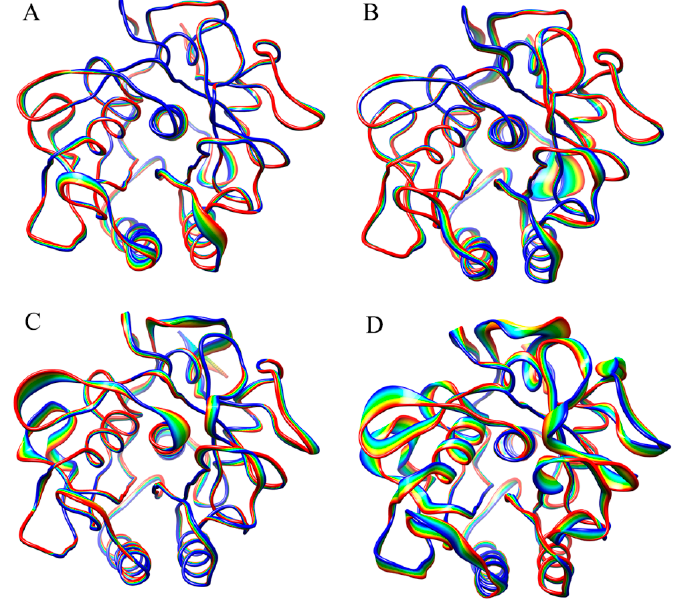
Figure 3. Projection extremes of the first eigenvector obtained from ED analyses of the joined trajectories at the four combined temperatures: ( A ) P180/S180; ( B ) P300/S180; ( C ) P180/S300; and ( D ) P300/S300. The linear interpolations between the two extremes are colored from blue to red to highlight conformational differences between these two states but do not represent the transition pathway.